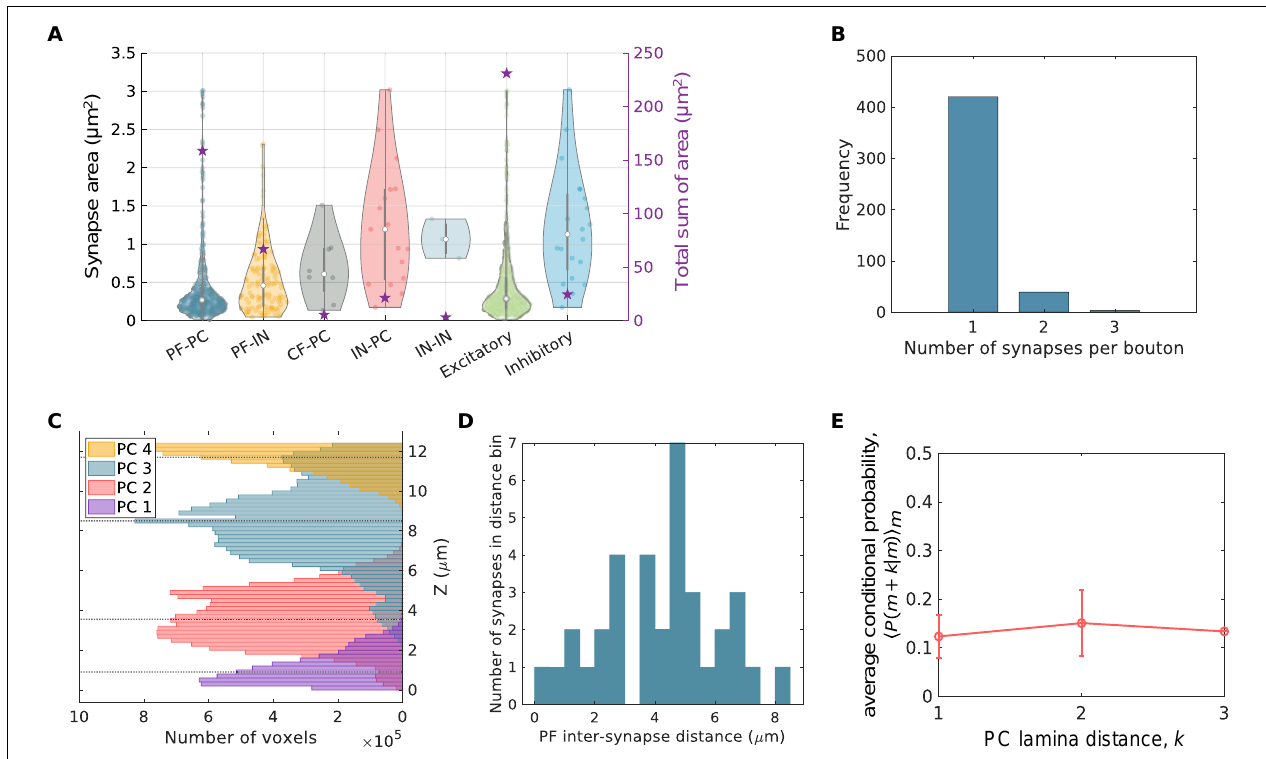
FIGURE 7 | Structural properties of the synapses and connectivity. (A) The size of the synapses measured by the contact area is shown grouped by the cell types or by excitatory (PF-PC, PF-IN, CF-PC) or inhibitory (IN-PC, IN-IN) types (left y-axis). The violin plots roughly show the distribution. The empty circles are the median, and the vertical gray bars range from the 25th to 75th percentiles. The total sum of the synapse area of each type is denoted by the star (right y-axis). (B) Frequency of the boutons with 1 ∼ 3 synapses. The boutons with 2 or more synapses are 9% (42 out of 462). (C) The volume distribution of the 4 PCs along the Z axis in the test set was calculated. The PCs have laminar organization, where each PC occupies one lamina. The dashed lines are the median for each distribution. The distance between adjacent PCs is estimated to be 4.5 ∼ 5.5 µ m, considering the fact that PCs 1 and 4 are cut off by the borders of the volume. (D) The histogram of inter-synapse intervals of PF-PC synapses. A peak near 5 µ m is coincident with the inter-PC distance in panel (C) . (E) The mean conditional probability that a PF connects also to PC ( m + k ), given that it connects to PC ( m ), averaged over m . The constant conditional probability implies that there is no correlation between the PF connections to different PCs. The error bars are standard